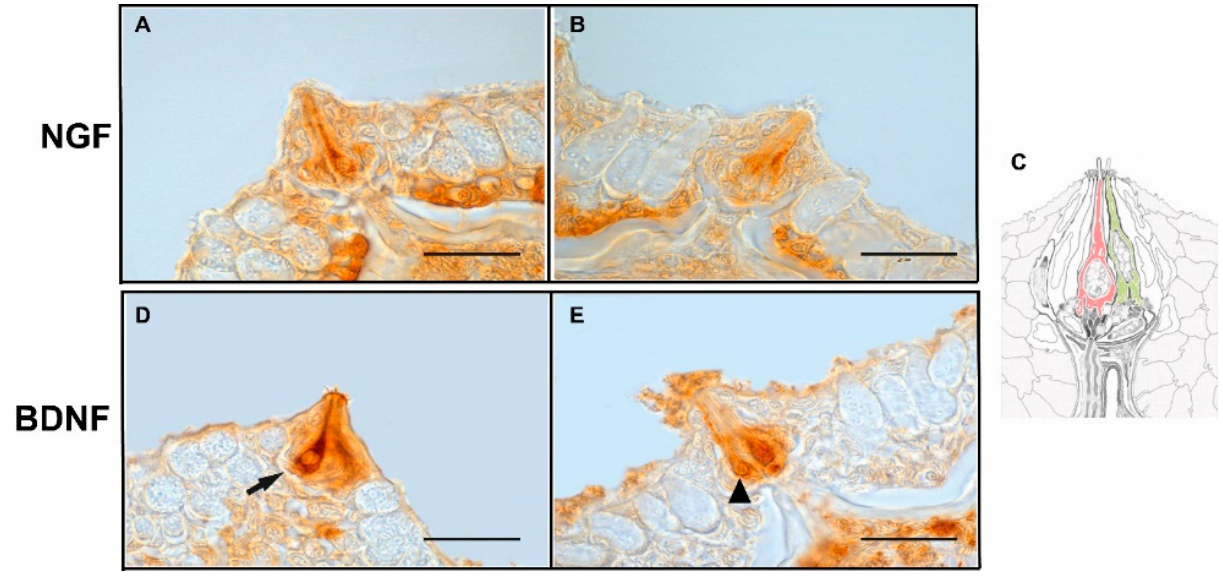
Figure 2. ( A , B ) NGF and ( D , E ) BDNF positive cells. ( C ) Taste bud scheme showing hypothetic congruence of positive cells with ultrastructural classification. The arrow indicates a putative light cell, while the arrowhead indicates a dark cell. Refer to color code in Figure 1 to recognize the cell type. Scale bar = 20 µ m.